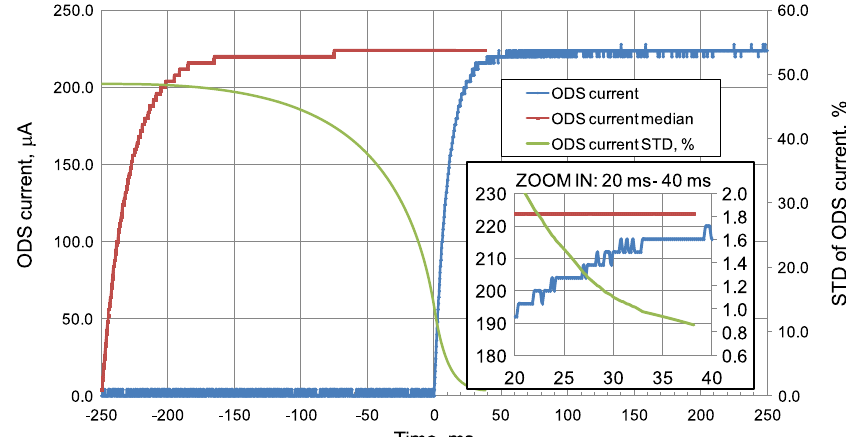
Fig. 10. Estimation of the median of the ODS current within the short pulse of width 25ms. The ODS measured current ( fi lter F633, DUT VSL085) and the standard deviations of the currents used for evaluation are shown as well. The zoomed part shows the end of the